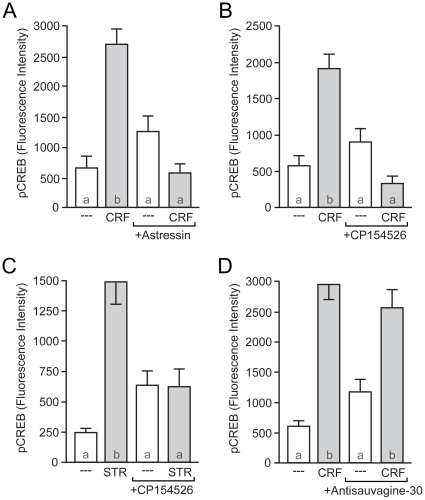
CRFR1 mediates CRF-induced CREB phosphorylation.(A) CRF-mediated CREB phosphorylation was blocked by the non-specific CRFR antagonist astressin (50 nM; F = 20.19), (B) and the CRFR1-specfic antagonist CP154526 (100 nM; F = 17.40). (C) CRF-induced CREB phosphorylation was mimicked by the CRFR1 agonist stressin-1 (STR; 70 nM). STR-induced CREB phosphorylation was also blocked by CP154526 (F = 15.99). (D) The CRFR2-specific antagonist antisauvagine-30 (100 nM) had no effect on CRF-induced CREB phosphorylation (F = 17.10).